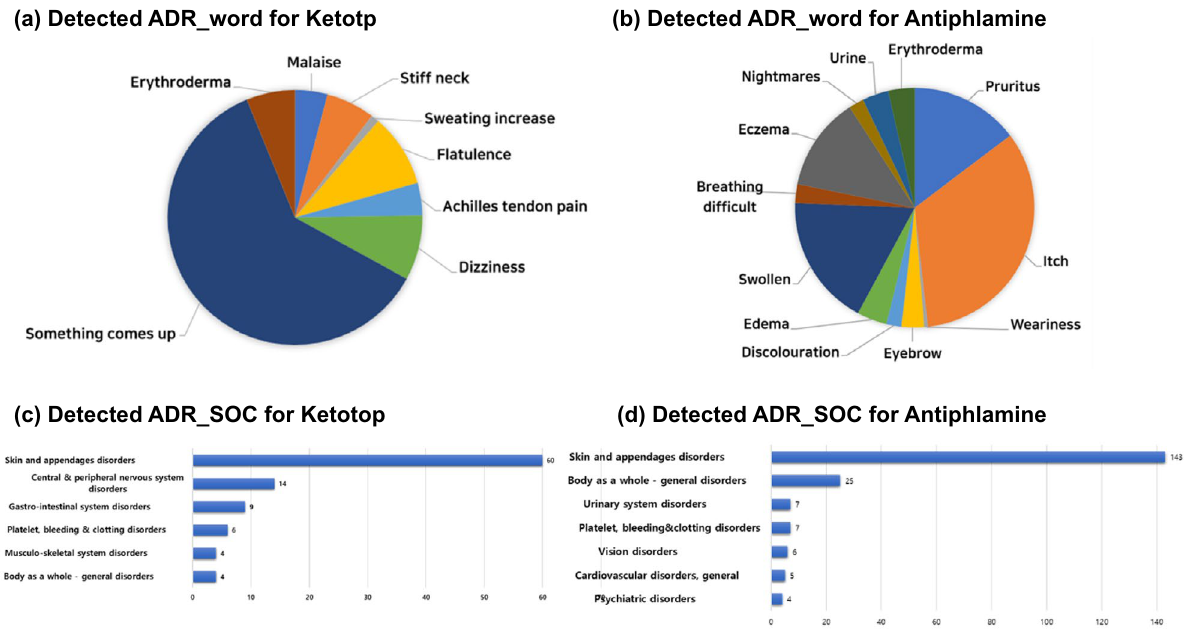
Figure 5. Graphs of each detected ADR word and SOC distribution for ketoprofen and antipuramine, which were the major drug names in the Drug Lexicon.